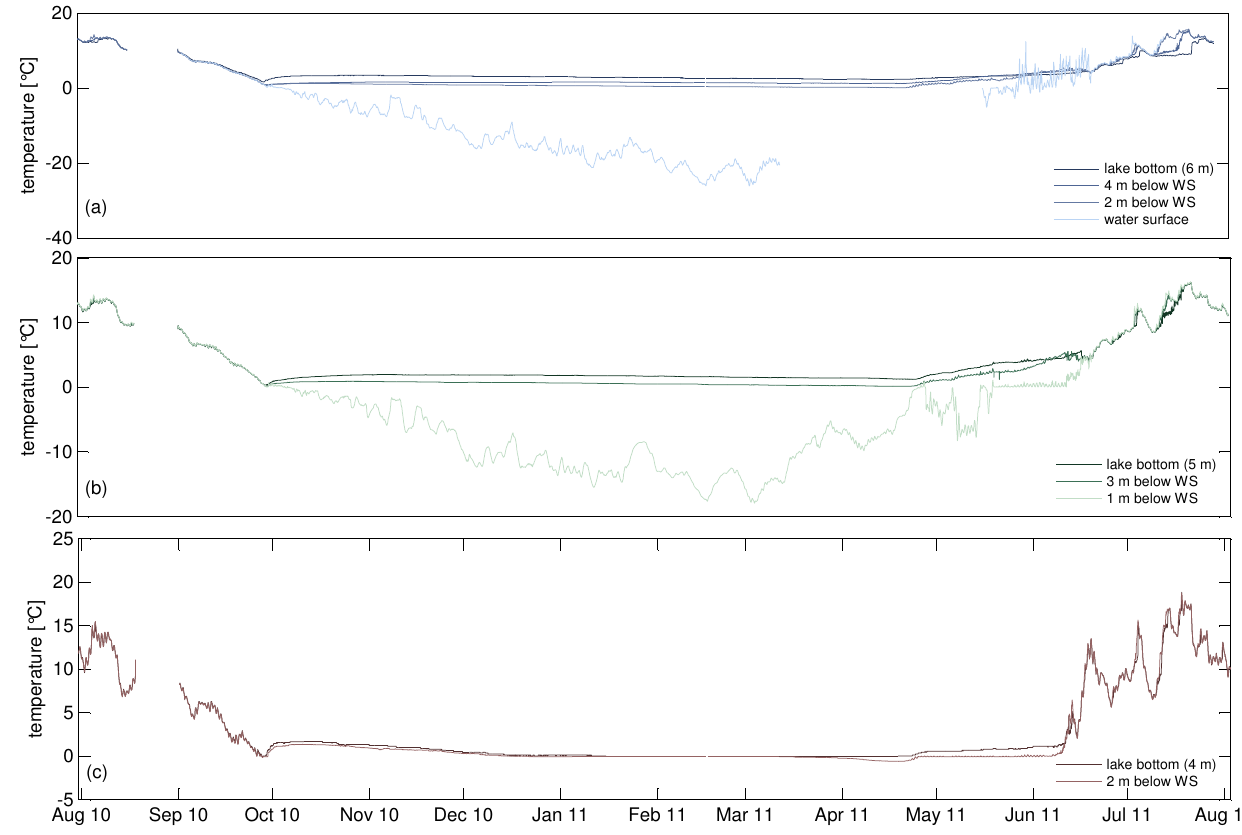
Fig. 14. Temperature dynamics in three thermokarst lakes for 2010–2011: (a) Lake 1, (b) Lake 2, and (c) Lake 3.